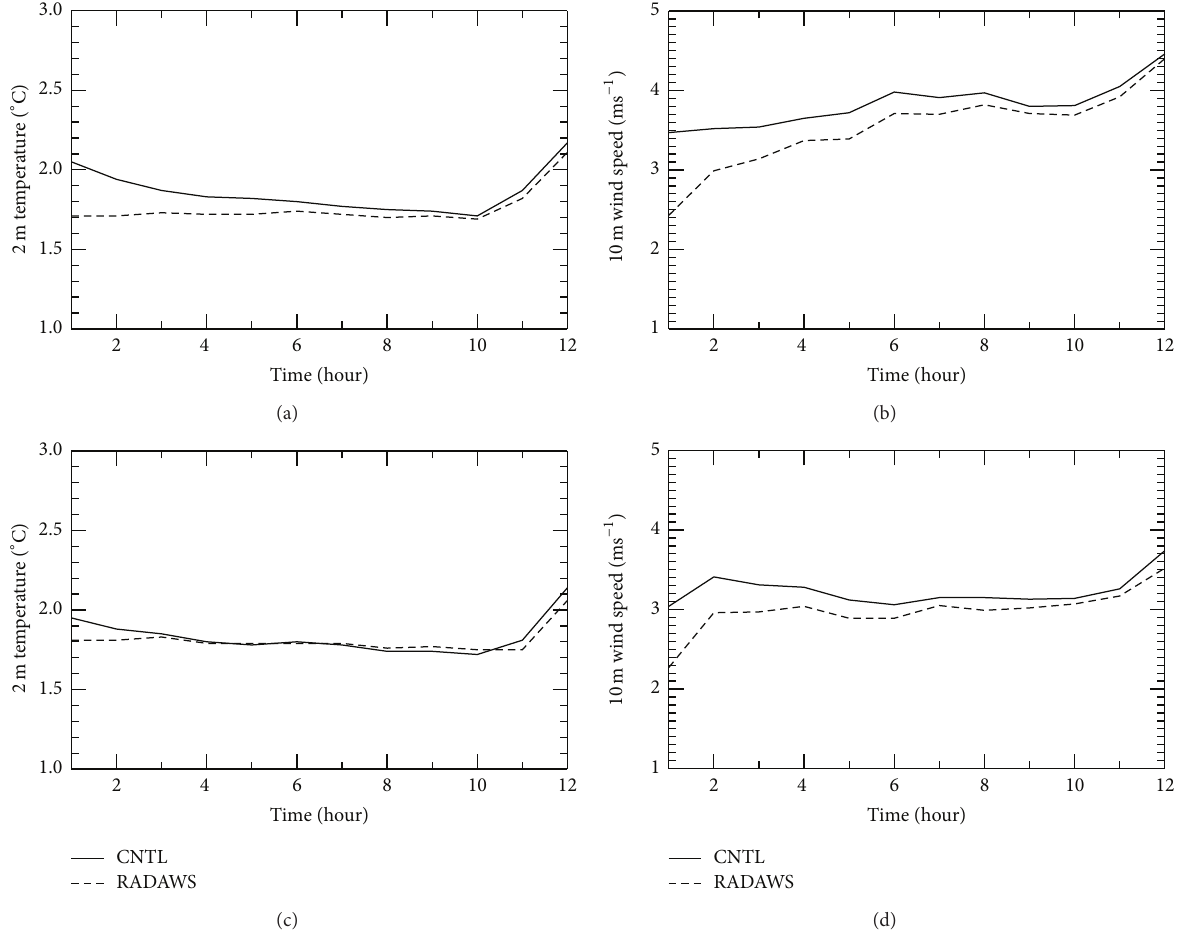
Figure 10: Time series of RMSEs for (a) 2m temperature and (b) 10m wind speed during the 12 h forecast for case 20110629 valid from 1300 UTC June 29 to 0000 UTC June 30 in the 4km domain and RMSEs for (c) 2 m temperature and (d) 10m wind speed during the 12h